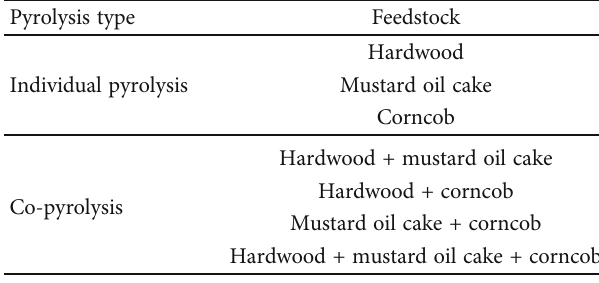
Table 1: Experimental